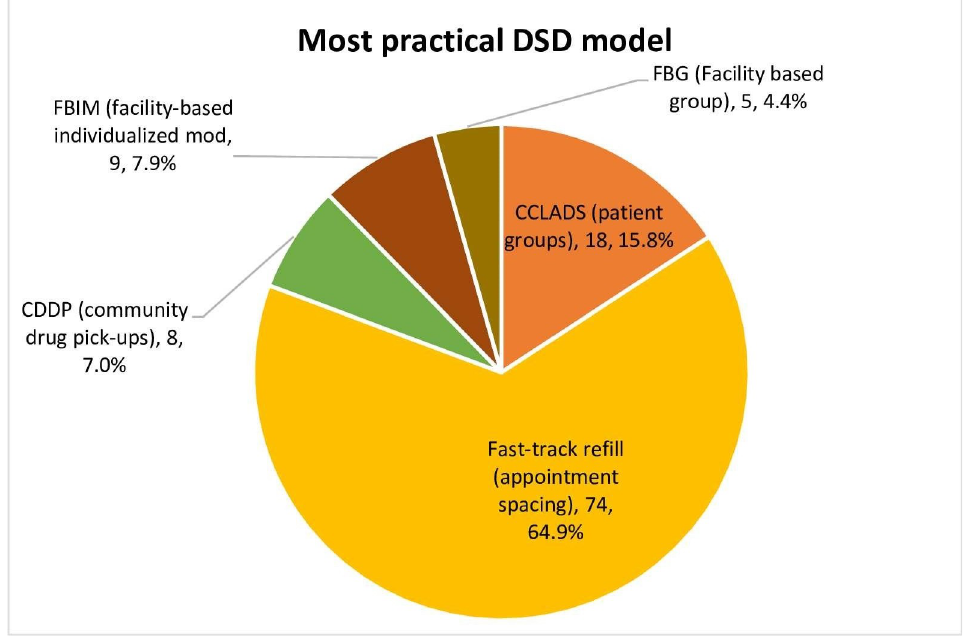
Fig 5. The most practical differentiated ART delivery